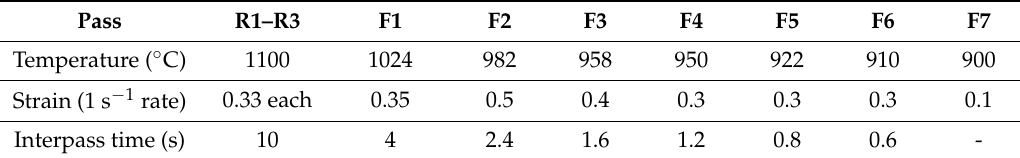
Figure 1. Summary of the various thermo-mechanical treatments employed in this study: path 1 for as-quenched condition, path 2 for isothermal age hardening treatments, and path 3 for coiling simulation. Table 2. Schedule for hot-torsion tests.